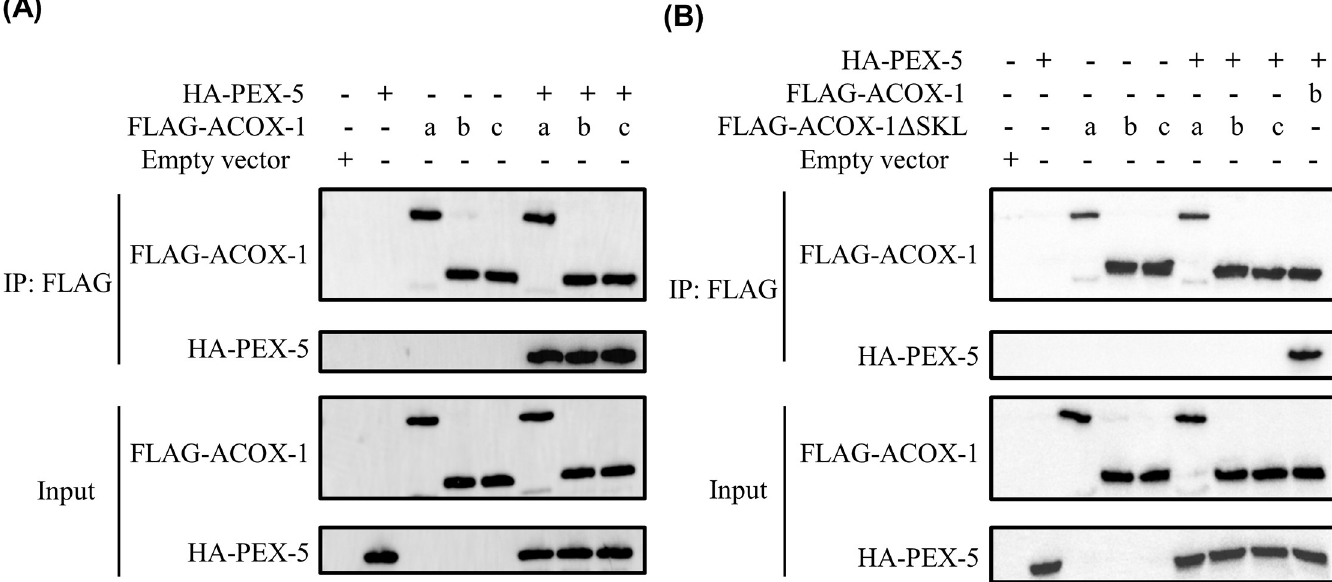
Fig 4. Interaction of Hc -ACOX-1 and Hc -PEX-5 via peroxisomal targeting signal type 1 (PTS1). (A-B) Co-expression of Hc- ACOX-1-FLAG with (A) or without (B) PTS1 and HA-tagged Hc -PEX-5 in HEK293T cells. Anti-FLAG antibody is used in immunoprecipitation (IP, top two panels) of the total cellular lysates (input, bottom tow panels). The immunoprecipitated portion and input are individually subjected to Western blot using anti-DYKDDDDK (FLAG) tag and anti-HA tag antibodies as labelled. The letters a, b and c represent Hc -ACOX-1.1, -1.2, and -1.3, respectively. Hc -ACOX-1.2 is used as positive control in (B). Δ SKL represents the deletion of